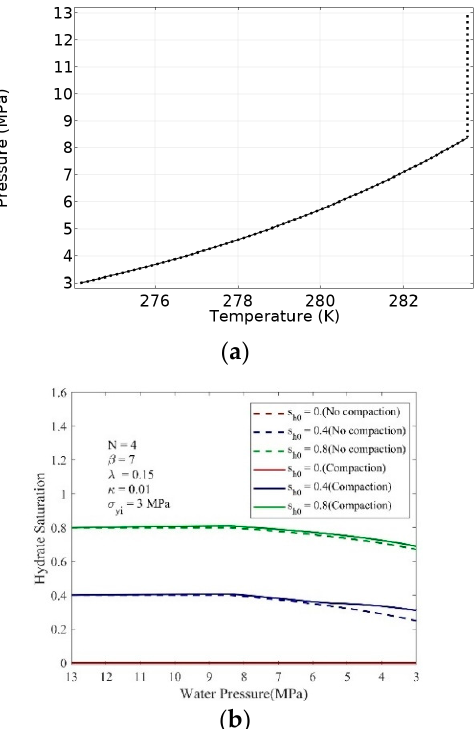
Figure 10. The variation of the ( a ) P–T path and ( b ) hydrate saturation during hydrate dissocia- tion.